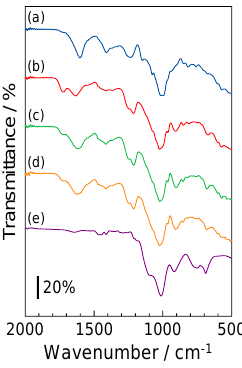
Figure 3. IR spectra of (a) fucoidan without combination with SiNSi, (b) F-5 wt% SiNSi composite, (c) F-10 wt% SiNSi composite, (d) F-20 wt% SiNSi composite, and (e) SiNSi without combination with fucoidan. The SiNSi without the composite of fucoidan was used as a sample that was condensed by heat treatment. Triplicate experiments gave similar results.